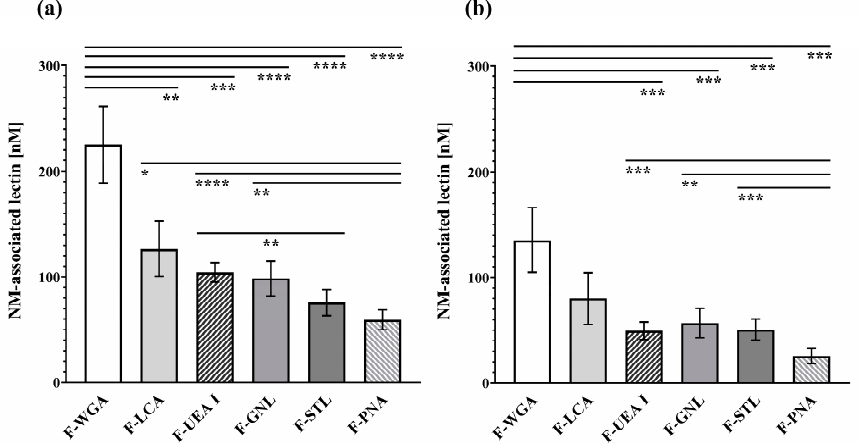
Figure 2. Lectin-binding capacity of the human nasal mucosa at ( a ) 4 ◦ C and ( b ) 37 ◦ C. Nasal mucosa (NM); Wheat germ agglutinin (WGA); Lens culinaris agglutinin (LCA); Ulex europaeus agglutinin 1 (UEA I); Galanthus nivalis lectin (GNL); Solanum tuberosum lectin (STL); and Peanut agglutinin (PNA). * p ≤ 0.05; ** p ≤ 0.01; *** p ≤ 0.001; and **** p ≤ 0.0001.